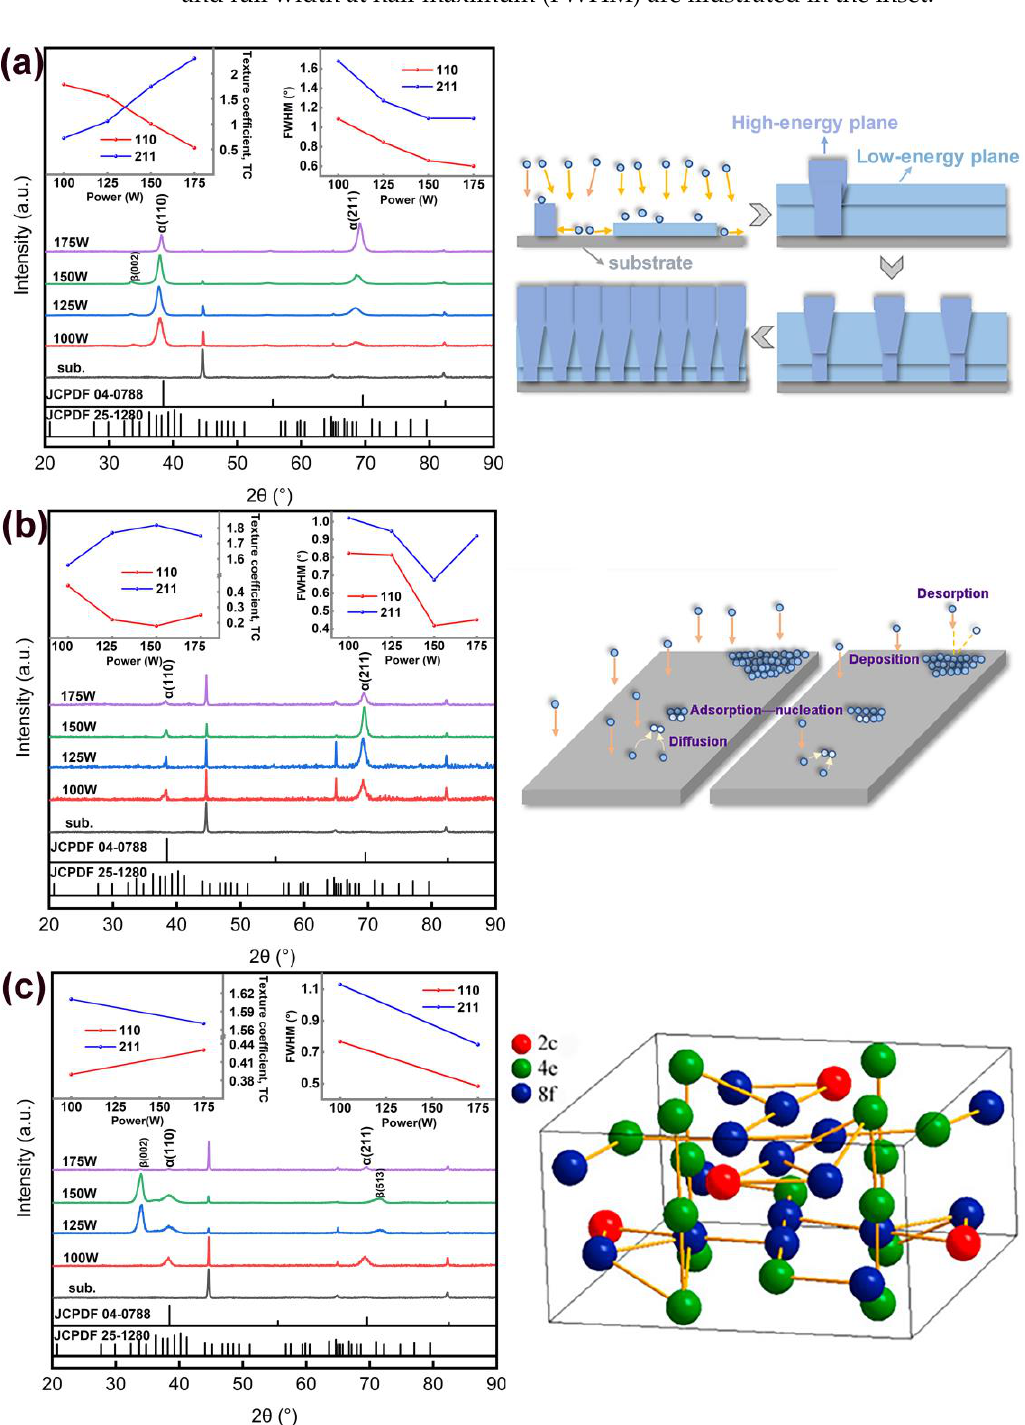
Figure 2. XRD patterns of Ta coatings at different T sub and P spu . ( a ) 200 °C, ( b ) 300 °C, and ( c ) 400 °C